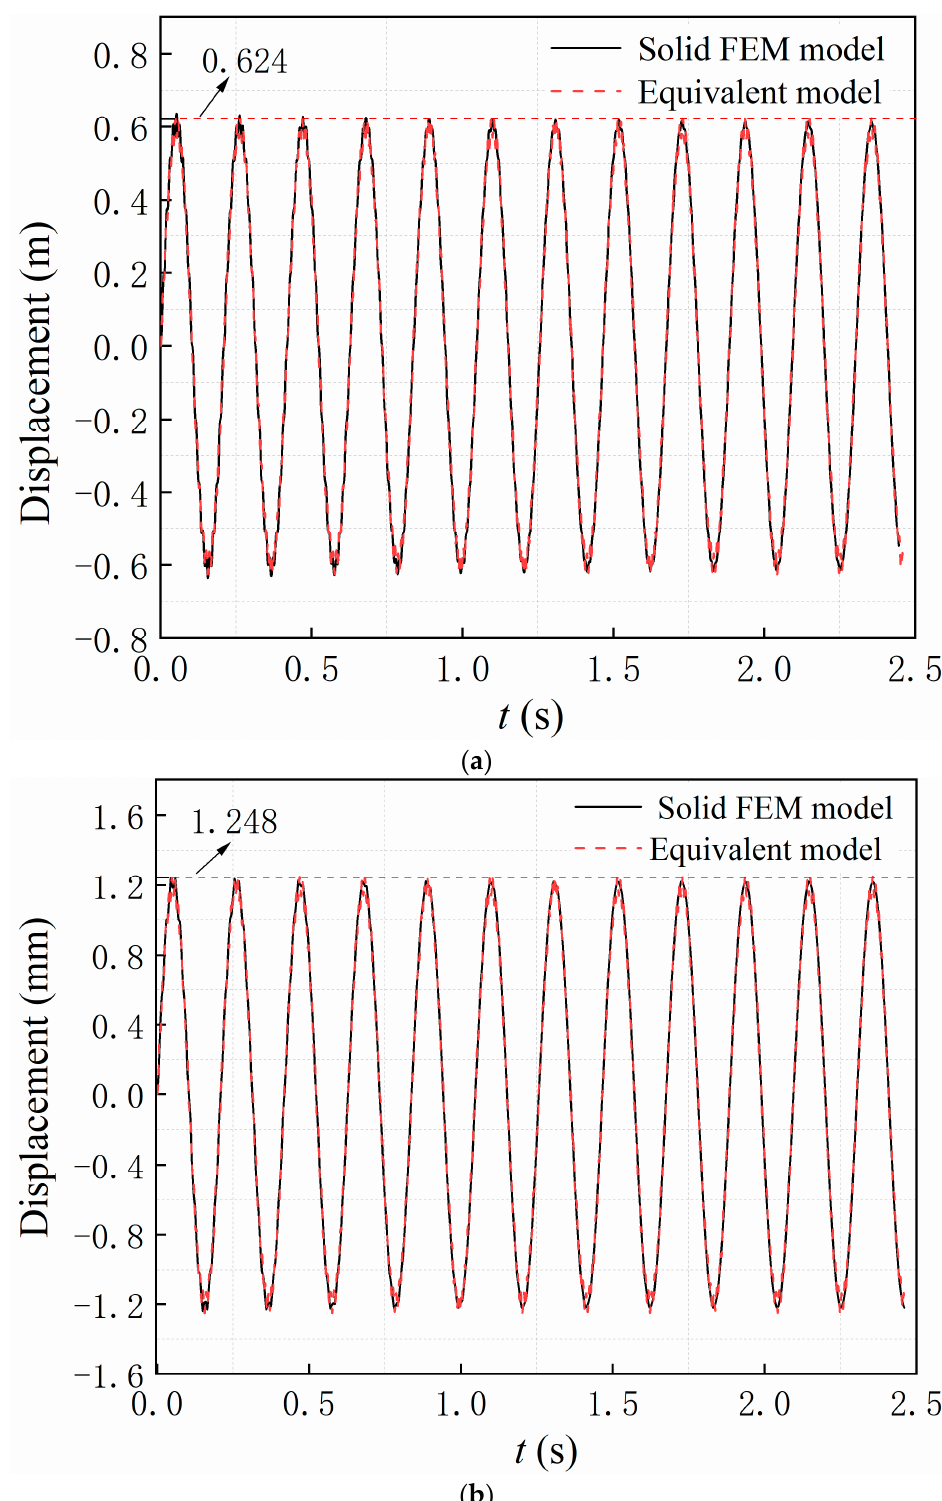
Figure 13. Dynamic responses of the bonded Timoshenko beam model under harmonic excitation with different excitation amplitude: ( a ) F 0 = 100 N ( b ) F 0 = 200 N.